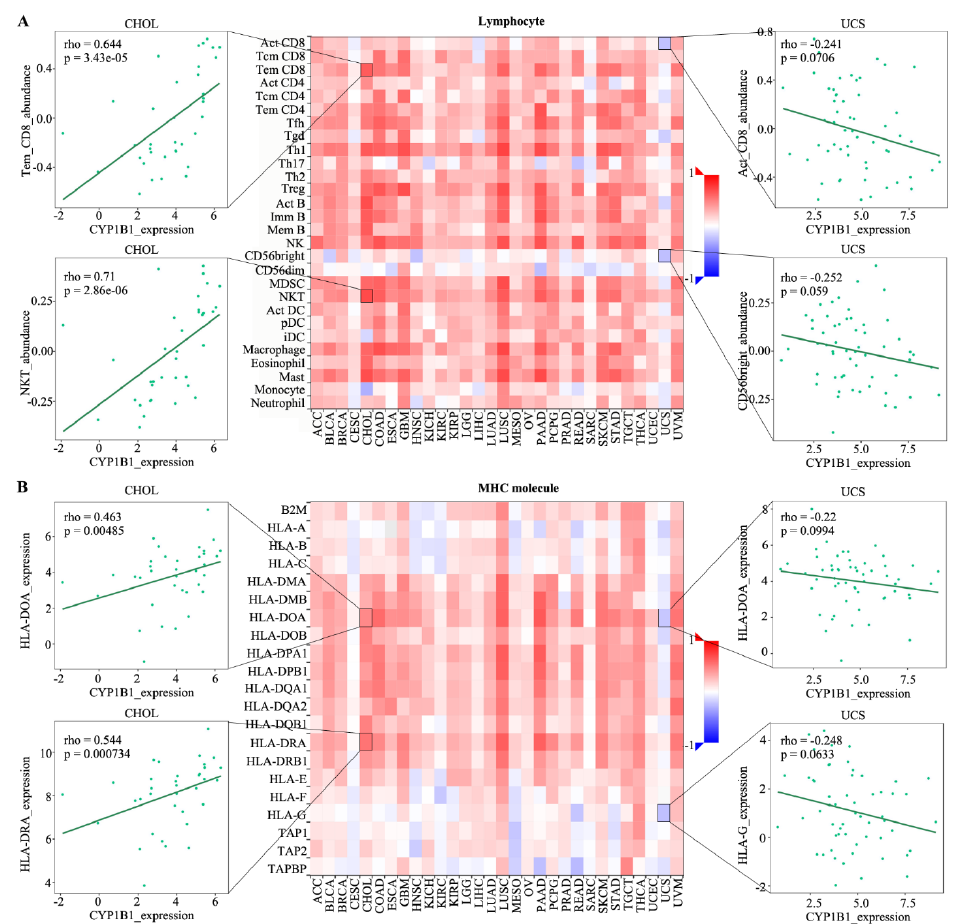
Figure 2. The correlations between CYP1B1 expression and lymphocyte and MHC molecule. ( A ) The spearman correlations between CYP1B1 expression and lymphocyte in cancer. ( B ) The spearman correlations between CYP1B1 expression and MHC molecule in cancer. The heatmap represents rho value. Red color means positive correlation, blue color means negative correlation. Four associations were showed by dot plots.